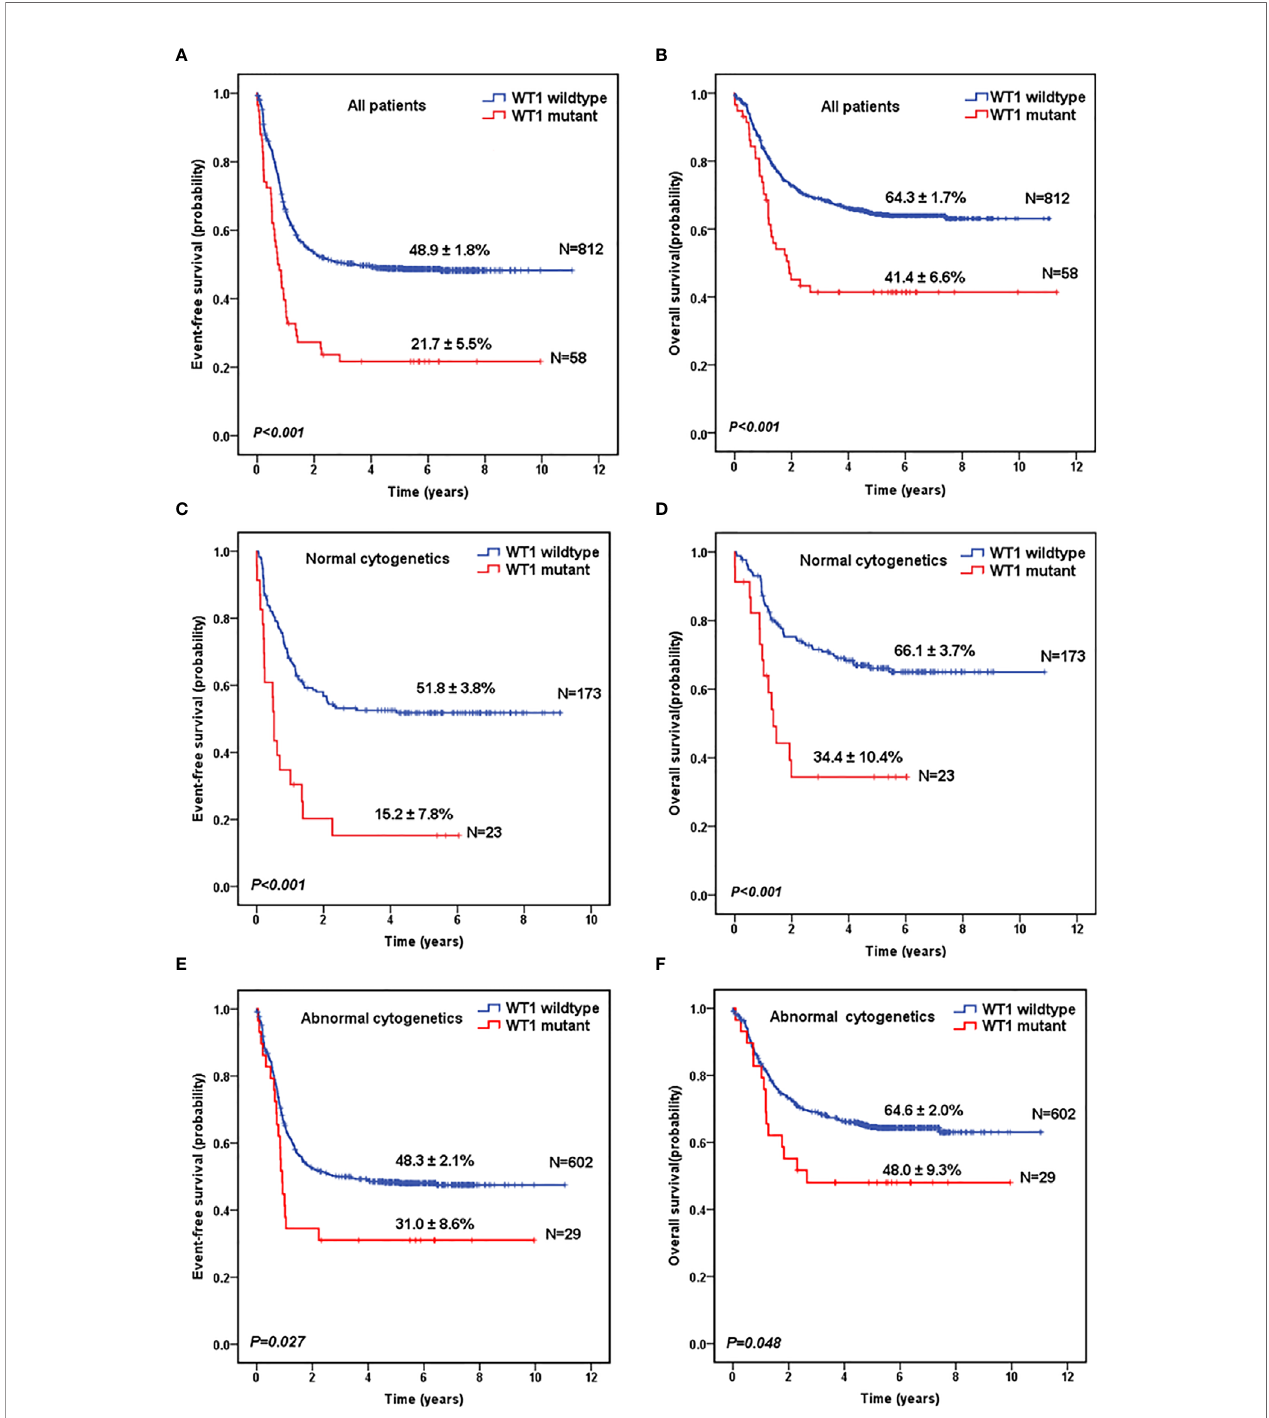
FIGURE 1 | Survival curves of pediatric AML patients with and without WT1 mutations. Probability of EFS (A) and OS (B) for all patients with and without WT1 mutations, respectively. Probability of EFS (C) and OS (D) for cytogenetically normal patients with and without WT1 mutations, respectively. Probability of EFS (E) and OS (F) for cytogenetically abnormal patients with and without WT1 mutations,